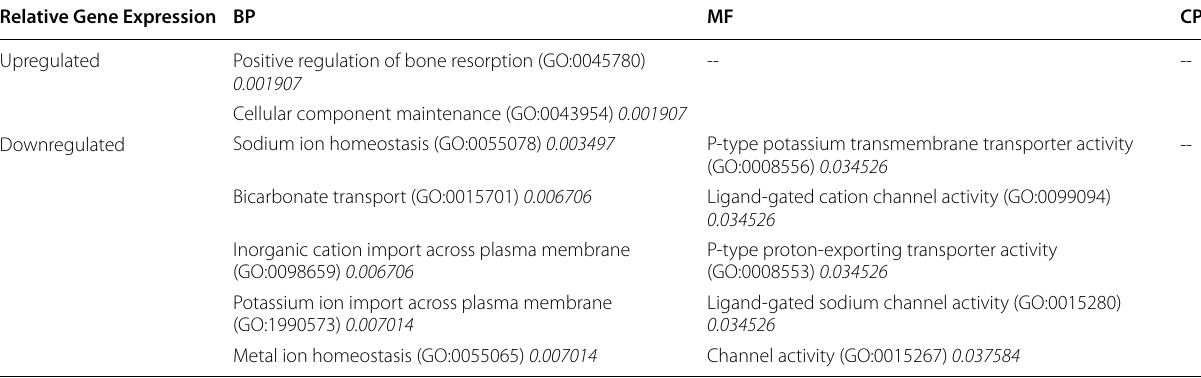
The Adjusted P -Value are mentioned in italics below the GO terms BP Biological Process, MF Molecular Function, CP Cellular Component --: No GO terms enriched with Adjusted P -Value